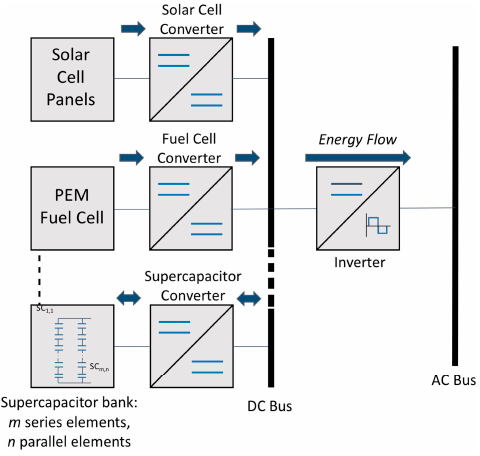
Figure 1. Distributed power generation systems (DPGSs).